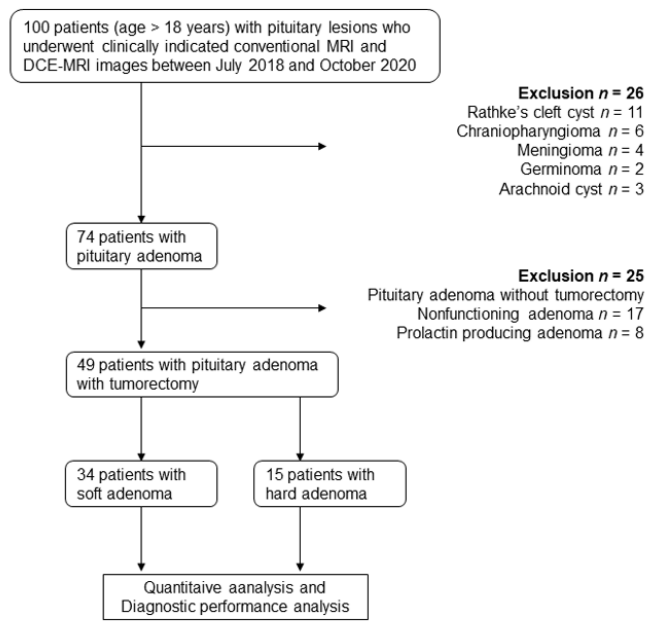
Figure 1. Study flowchart for the inclusion and exclusion criteria of the participant sample and pituitary lesion characterization. DCE-MRI: dynamic contrast-enhanced MRI. Table 2. Characteristics of participants and adenomas.